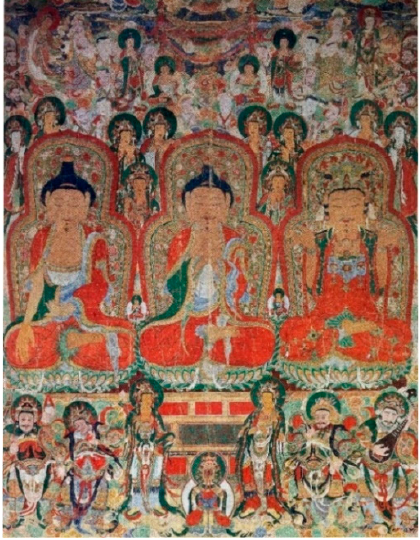
Figure 3. Assembly of the Trikaya (K. Samsinbulhoedo) , Joseon (1650), Color on hemp, 1086 × 841 cm, Gapsa Temple (Research Institute of Sungbo Cultural Heritage 2000a, p. 15).